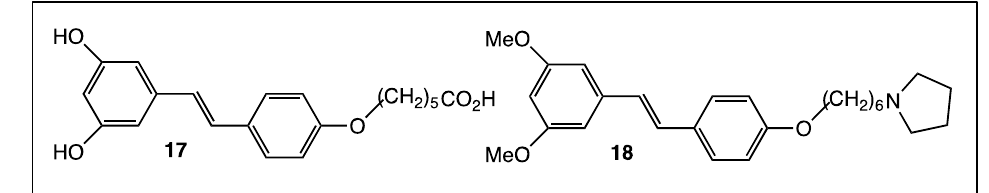
Figure 9 . Structure of resveratrol aliphatic acid 17 and resveratrol aliphatic amine 18 .